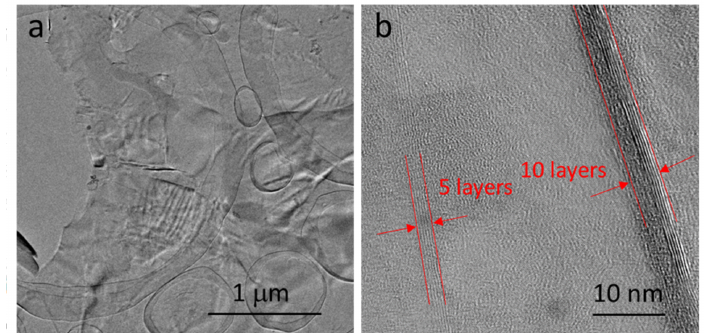
Figure 3. High-resolution transmission electron microscope (HRTEM) images of the graphene film on the surface of Ni–P–G: ( a ) enlarged view; ( b ) edges of the graphene